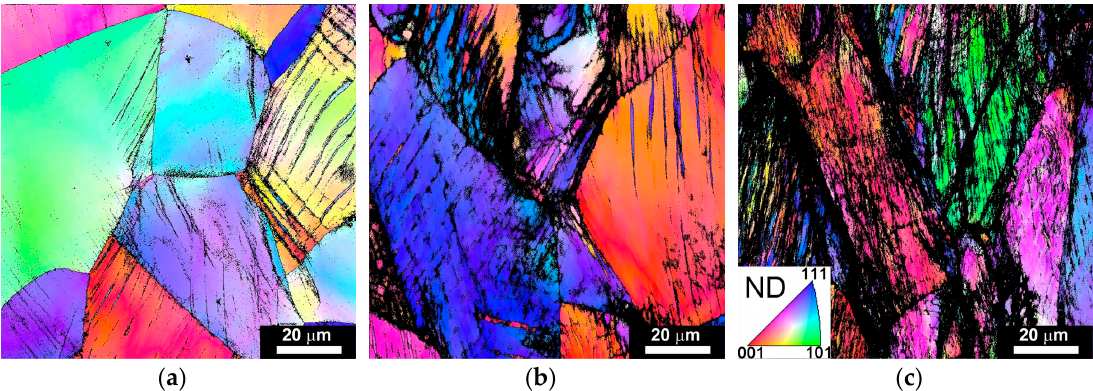
Figure 1. Deformation microstructures in a high-Mn steel subjected to rolling reduction of 20% ( a ); 40% ( b ); 60% ( c ). Low-angle and high-angle boundaries are indicated by thin and thick black lines, respectively. Color orientations are shown for the normal direction (ND).